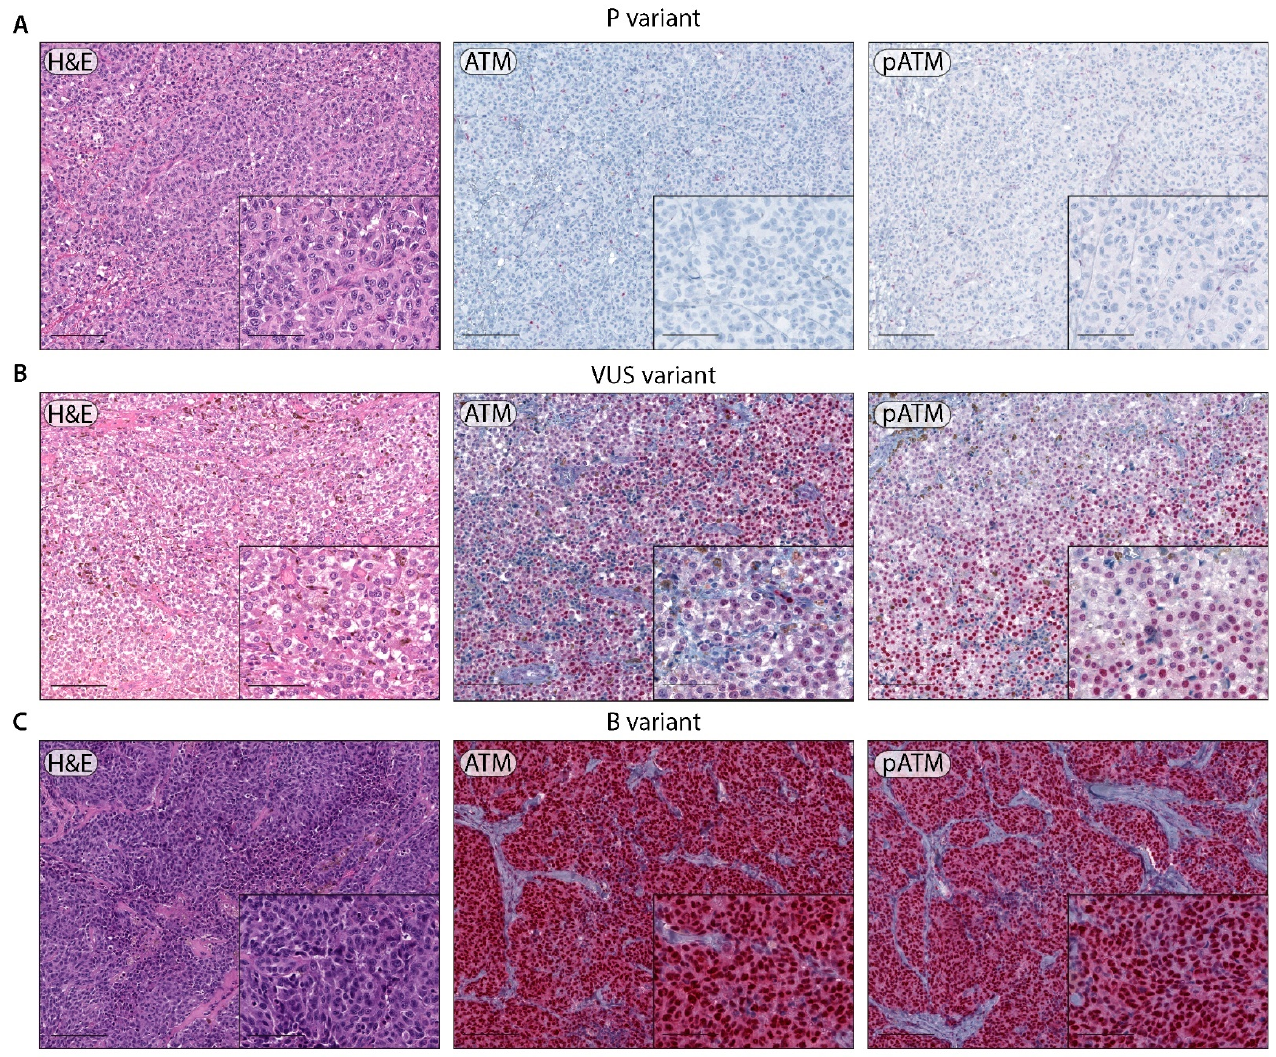
Figure 2. Representative images of ATM and pATM expression by immunohistochemistry. ( A ) Metastatic melanoma with pathogenic ATM variant (p.Ser1993ArgfsTer23), showing a lack of ATM and pATM nuclear expression in tumor cells (magnification 10X, inset 20X; scale bars 200 μ m and 100 μ m, respectively). ( B ) Metastatic melanoma with ATM variant of uncertain significance (p.Asn796His), showing partial conservation of nuclear expression for ATM and for pATM (magnification 10X, inset 20X; scale bars 200 μ m and 100 μ m, respectively). ( C ) Skin melanoma metastasis with benign ATM variant (p.Pro604Ser) showing nuclear ATM and pATM staining (magnification 10X, inset 20X; scale bars 200 μ m and 100 μ m, respectively).